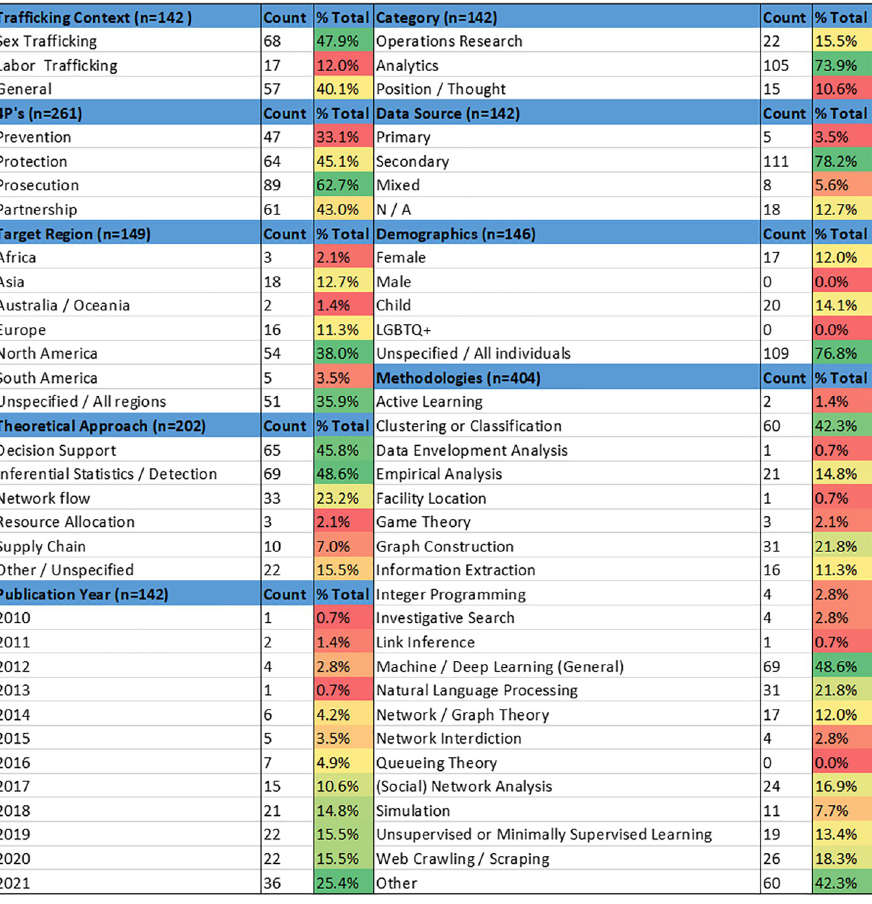
Fig 4. Summary statistics for the set of 142